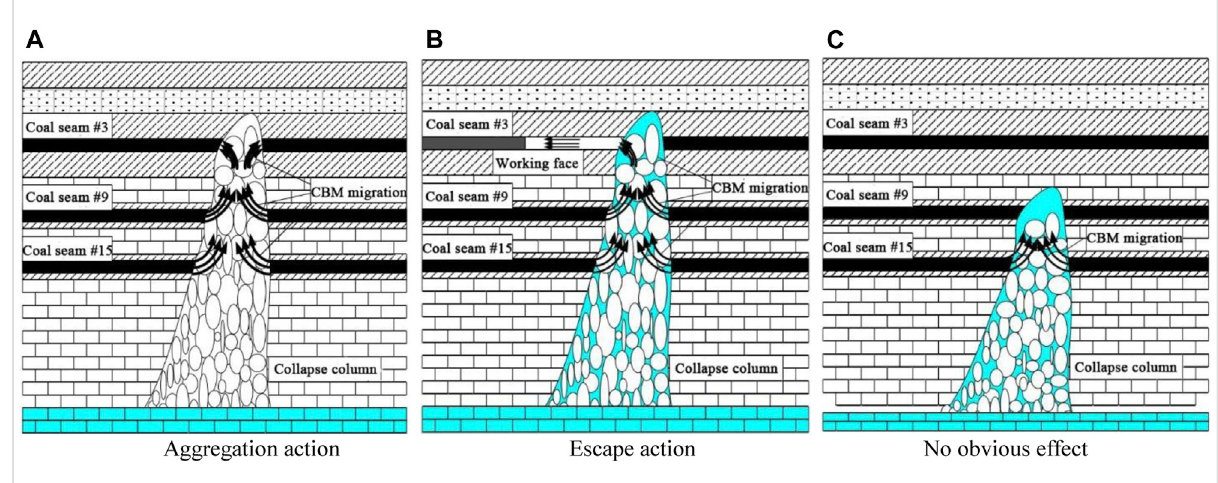
FIGURE 10 Different control effects of collapse column on the occurrence of CBM.